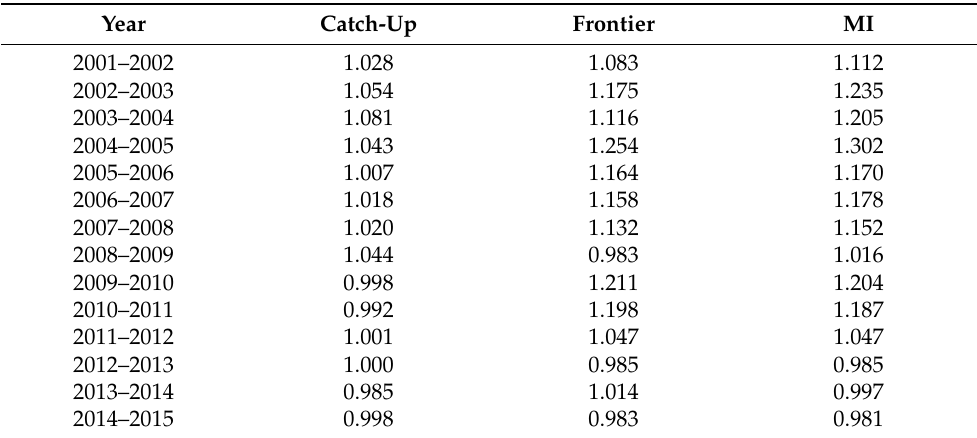
Table 5. 2001–2015 Malmquist index of high-polluting industry and its breakdown.